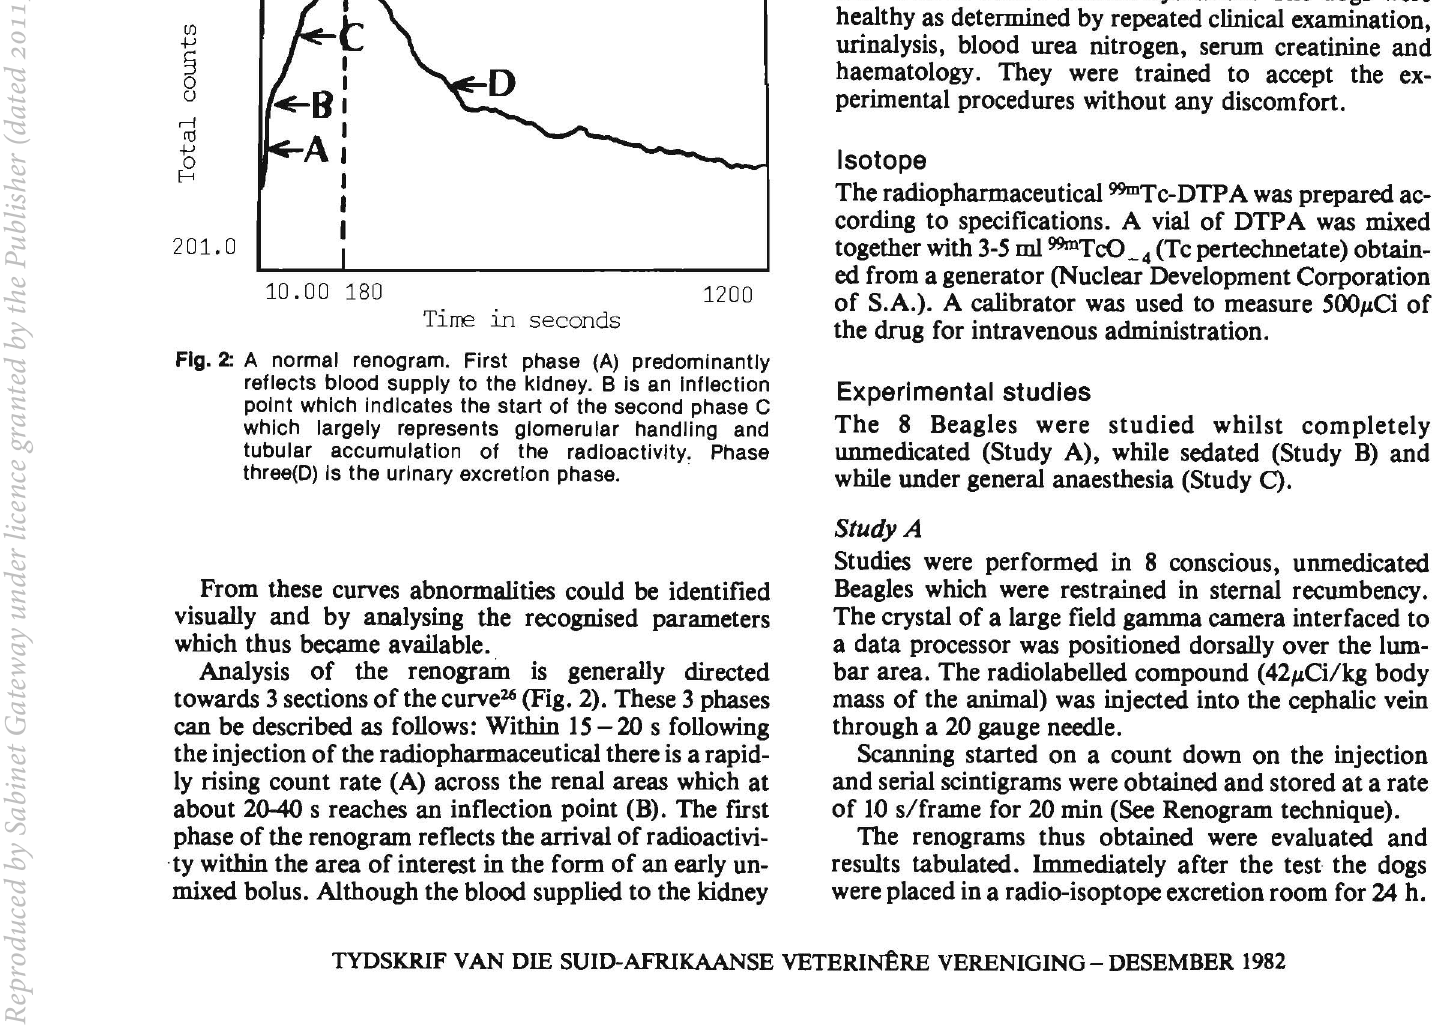
Fig. 2: A normal renogram. First phase (A) predominantly reflects blood supply to the kidney. B Is an Inflection point which Indicates the start of the second phase C which largely represents glomerular handling and tubular accumulation of the radioactivity. Phase three(O) Is the urinary excretion phase.